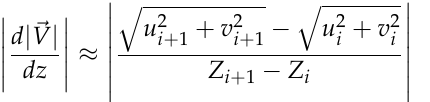
Figure 7. Scatterplots showing the relationship between PD (hPa) and WSD (m/s) of GK2A IR winds derived using the EBBT method in each atmospheric layer at ( a ) 200–400 hPa, ( b ) 400–600 hPa and ( c ) 600–800 hPa in the extratropics. QIFY threshold of 90 is applied. The AMV height assignment errors and speed biases are greater in areas with large vertical wind shear. Figure 8 shows the zonal plot of wind shear and PD, speed bias and RMSVD of GK2A IR winds and H-8 IR winds. The vertical wind shear is calculated using the vertical change in wind speed as follows to simply analyze the quantitative correlation between wind speed bias and vertical wind shear: